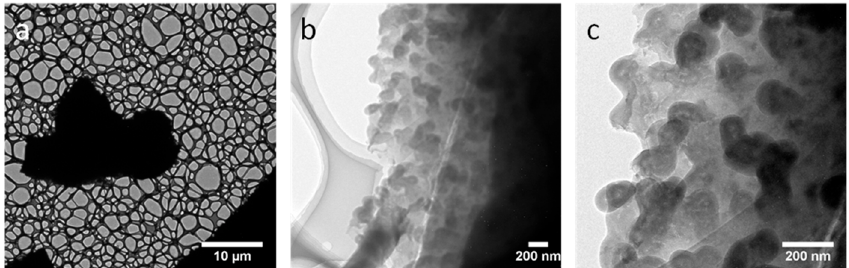
Figure 8. Electron microscopy images of carbonized material obtained at a lower flame temperature. Lower temperature burning, as in Sample 1b, leads to higher level of tortuosity, probably due to slower growth of fingers. Pictures are shown in order of increased magnification. ( a ) A piece of combusted spaghetti between two grids; ( b , c ) twisted fingers at the surface of the carbonized biomass.